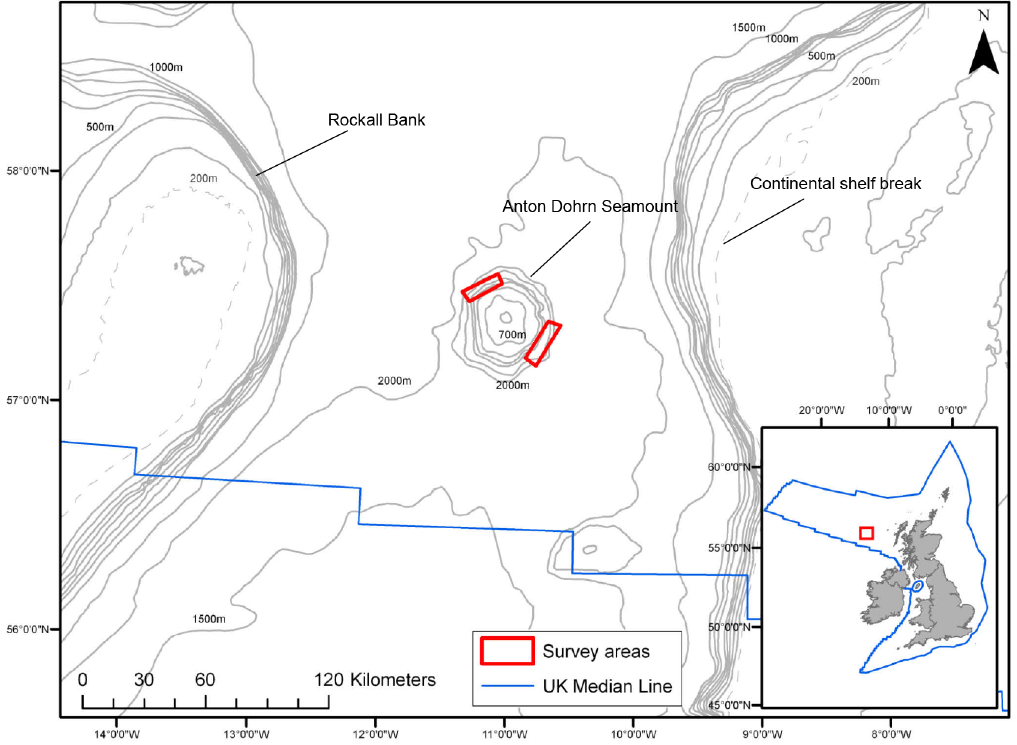
Fig 1. The study area west of Scotland, UK. Survey areas on the NW and SE sides of Anton Dohrn Seamount are marked. Bathymetric contours are provided by GEBCO, the 200 m depth contour (dashed line) marks the approximate position of the continental shelf break.